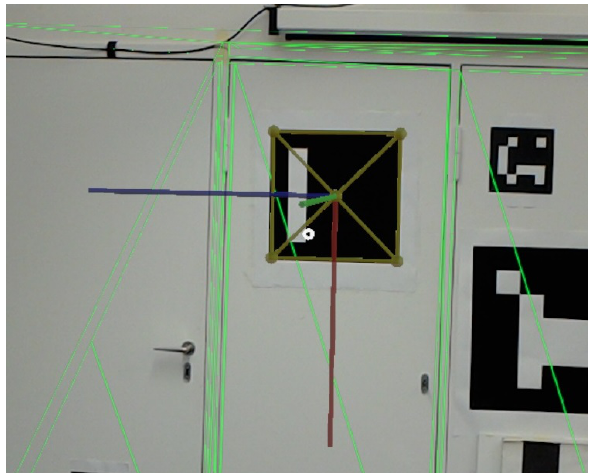
Figure 3. The ArUco marker used for localization augmented with a virtual representation of the marker and the coordinate frame of the room model.